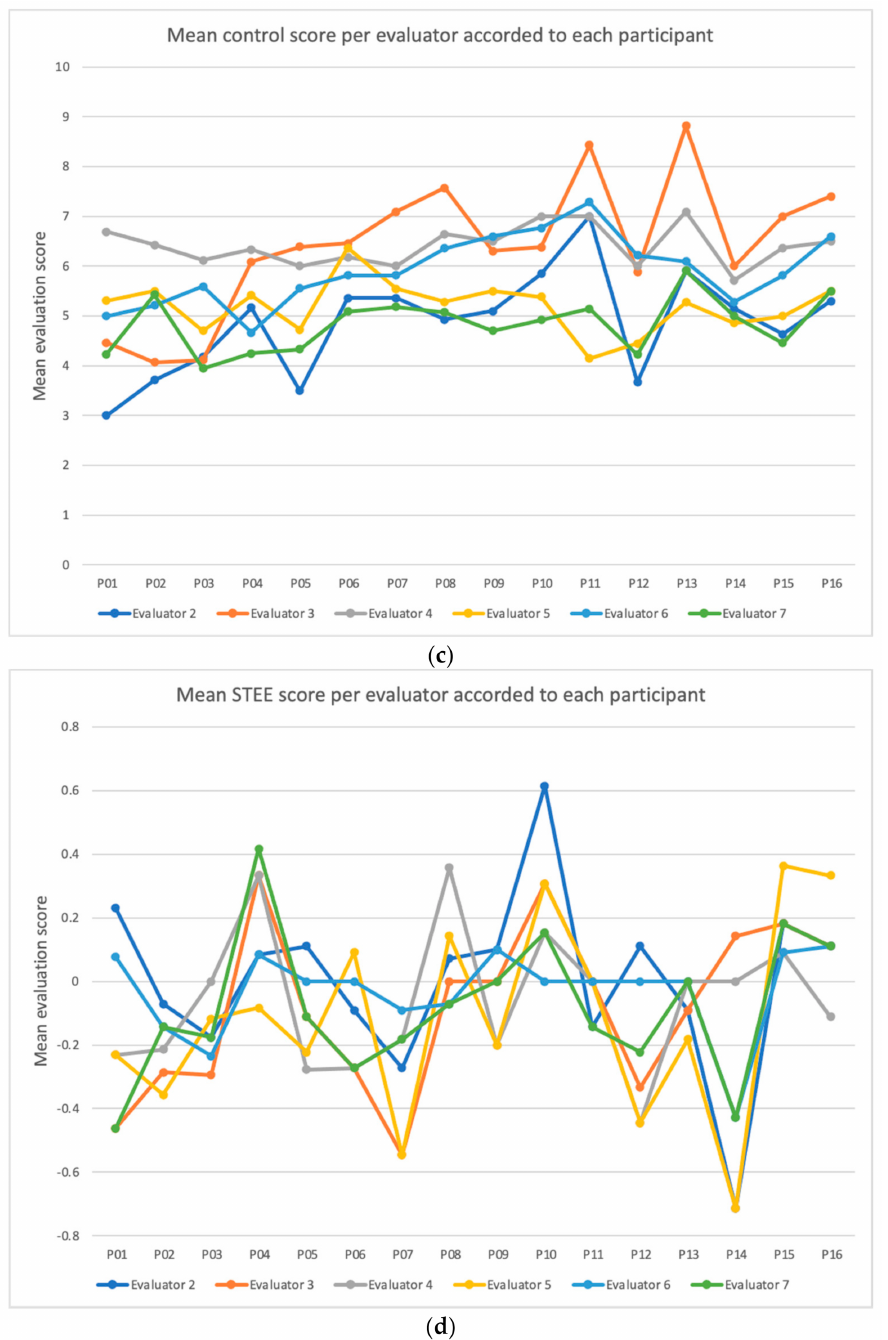
Figure 5. ( a – d ) The evaluator scores of the dimensions of valence, arousal, and control are a function of the 9-point SAM scale, whereas the evaluator score of the dimension of STEE ranges from − 2 to 2. ( a ) Mean valence score per evaluator accorded to each participant. ( b ) Mean arousal score per evaluator accorded to each participant. ( c ) Mean control score per evaluator accorded to each participant. ( d ) Mean STEE score per evaluator accorded to each